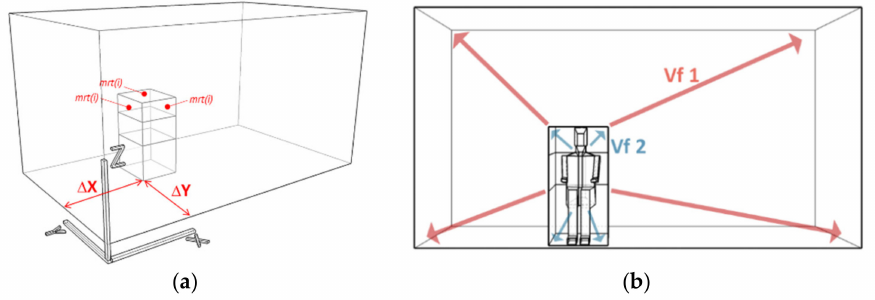
Figure 4. ( a ) Three MRT sensor boxes within the Esp-r zone; ( b ) calculation of the view factor set Vf1 between the MRT sensor boxes and the zone and the constant precalculated view factor set Vf2 between the manikin and the MRT sensor boxes